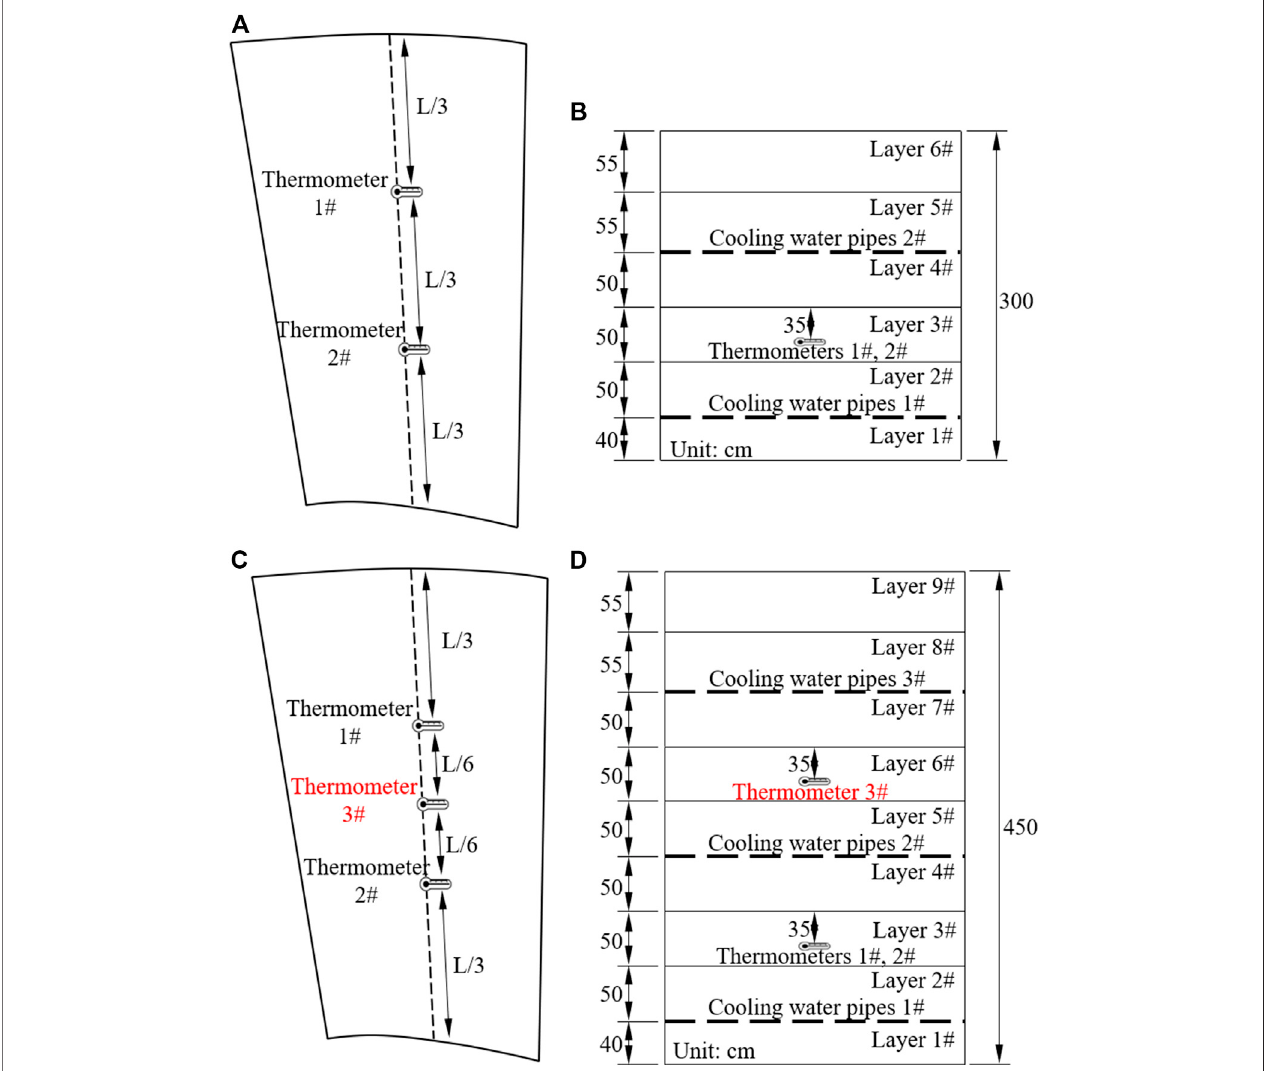
FIGURE 8 | Position of thermometers in concrete blocks above EL910m: (A) in horizontal direction (3 m); (B) in vertical direction (3 m); (C) in horizontal direction (4.5 m); (D) in vertical direction (4.5 m).